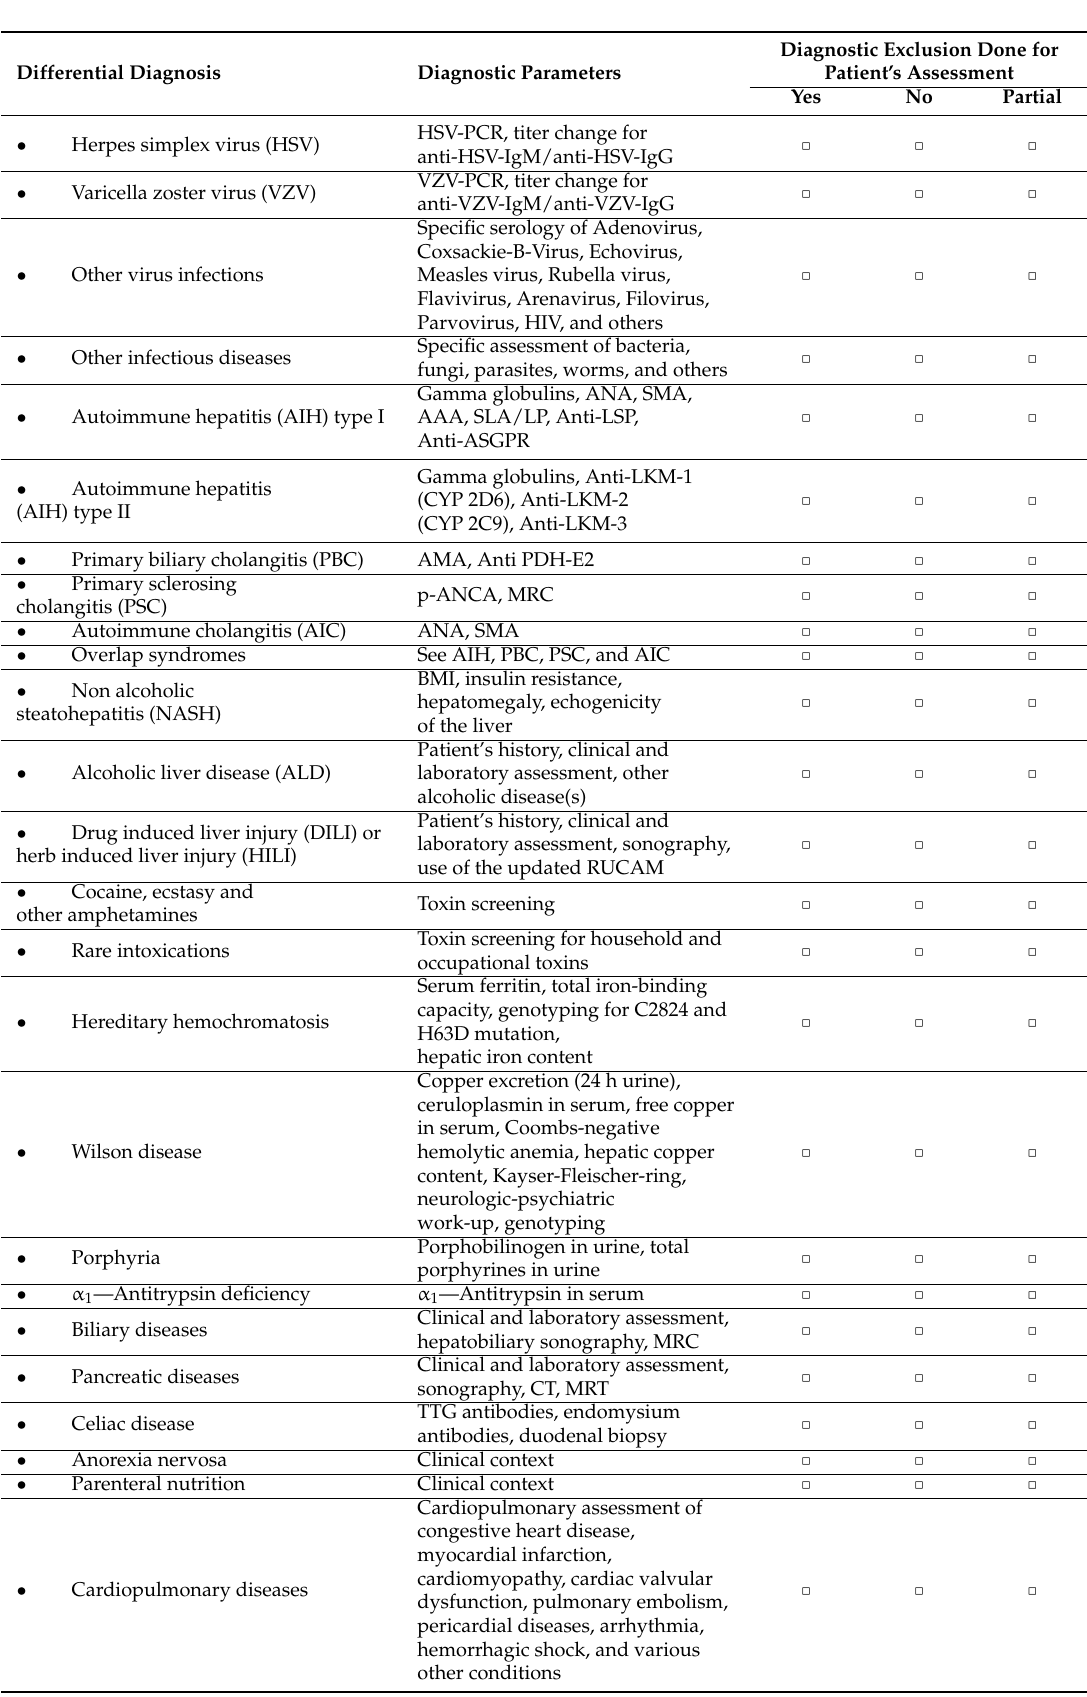
Differential Diagnosis Diagnostic